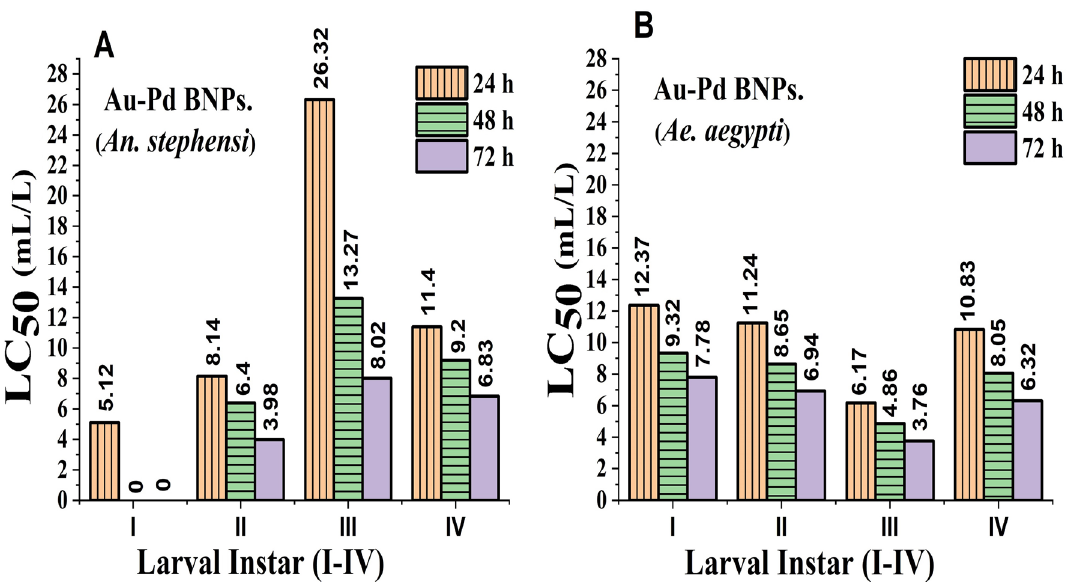
Figure 10. LC 50 observed in the test concentrations of Au–Pd BNPs bioassay against I-IV instar larval stages of: ( A ) larvae of Anopheles stephensi mosquito; ( B ) larvae of Aedes aegypti